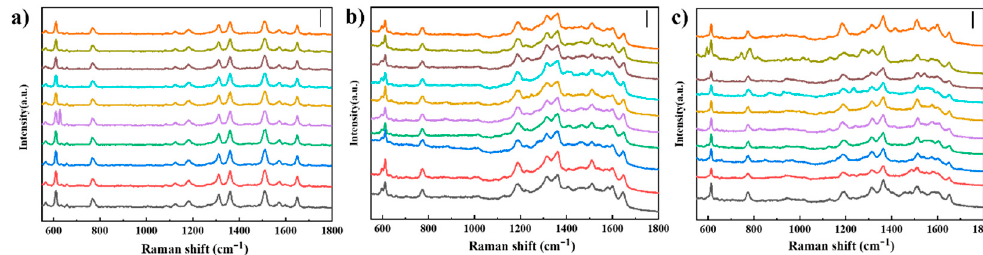
Figure 5. 10 point Raman measurements on different SERS substrates. ( a ) R6G Raman detection by S-SiNRs@AuNPs, scale: 2000; ( b ) R6G Raman detection by T-SiNRs@AuNPs, scale: 4000; ( c ) R6G Raman detection by B-SiNRs@AuNPs, scale: 3000. The 10 measuring points were selected randomly to cover the sample.